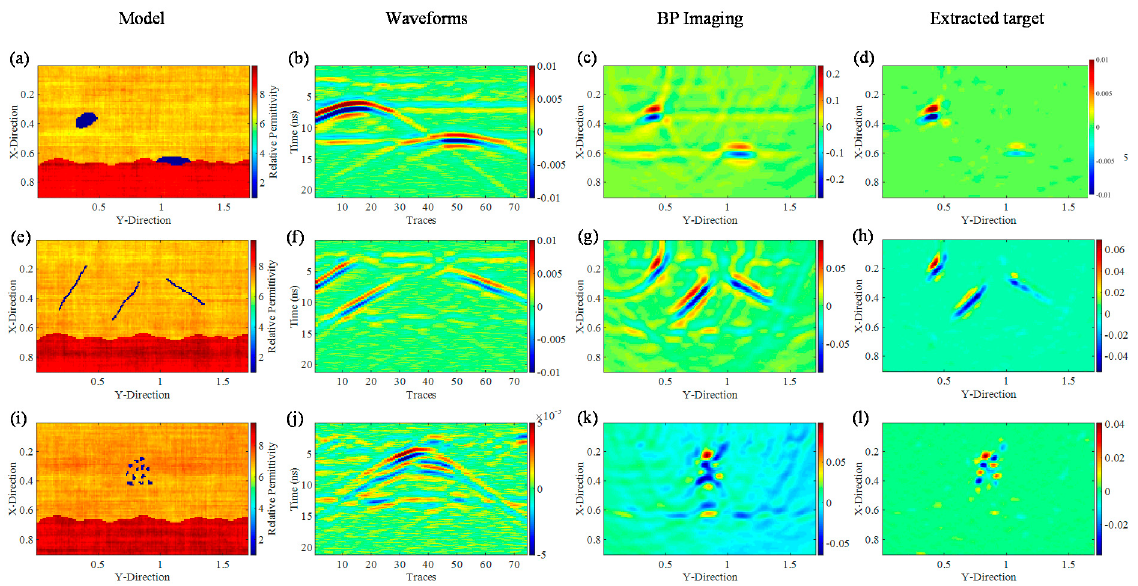
Figure 6. ( a – d ) represent the lining voids and lining-rock separation model, waveform, BP imaging, and extracted target, respectively; ( e – h ) represent the lining fractures model, waveform, BP imaging, and extracted target, respectively; ( i – l ) represent the concrete honeycomb model, waveform, BP imaging, and extracted target, respectively.